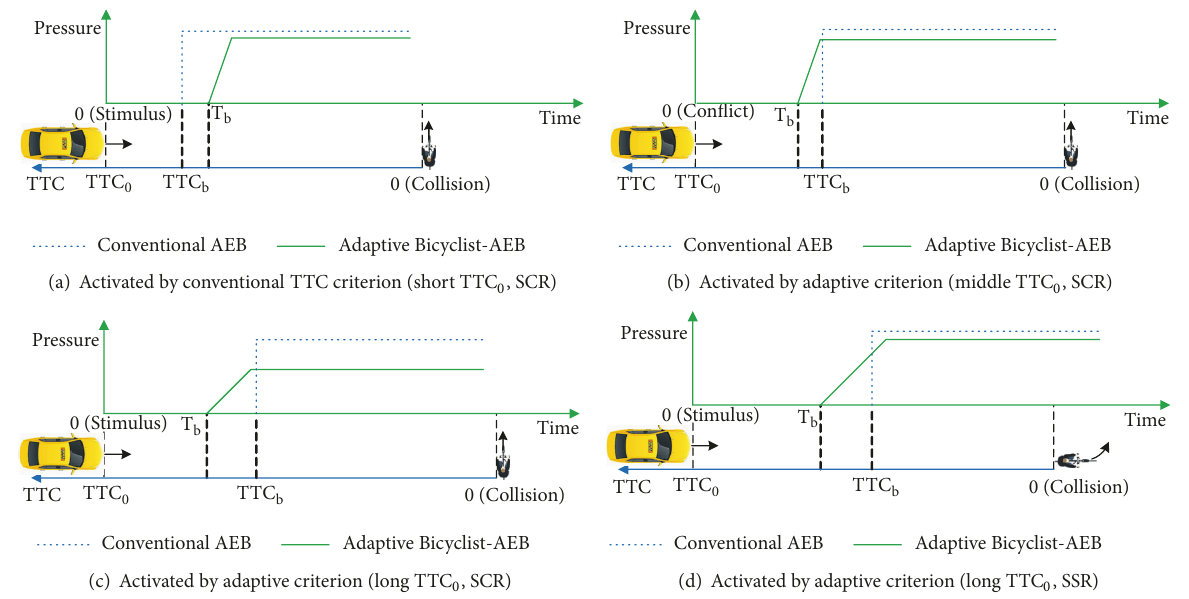
Figure 16: Comparison between conventional AEB and adaptive Bicyclist-AEB on activation timing and brake phases.